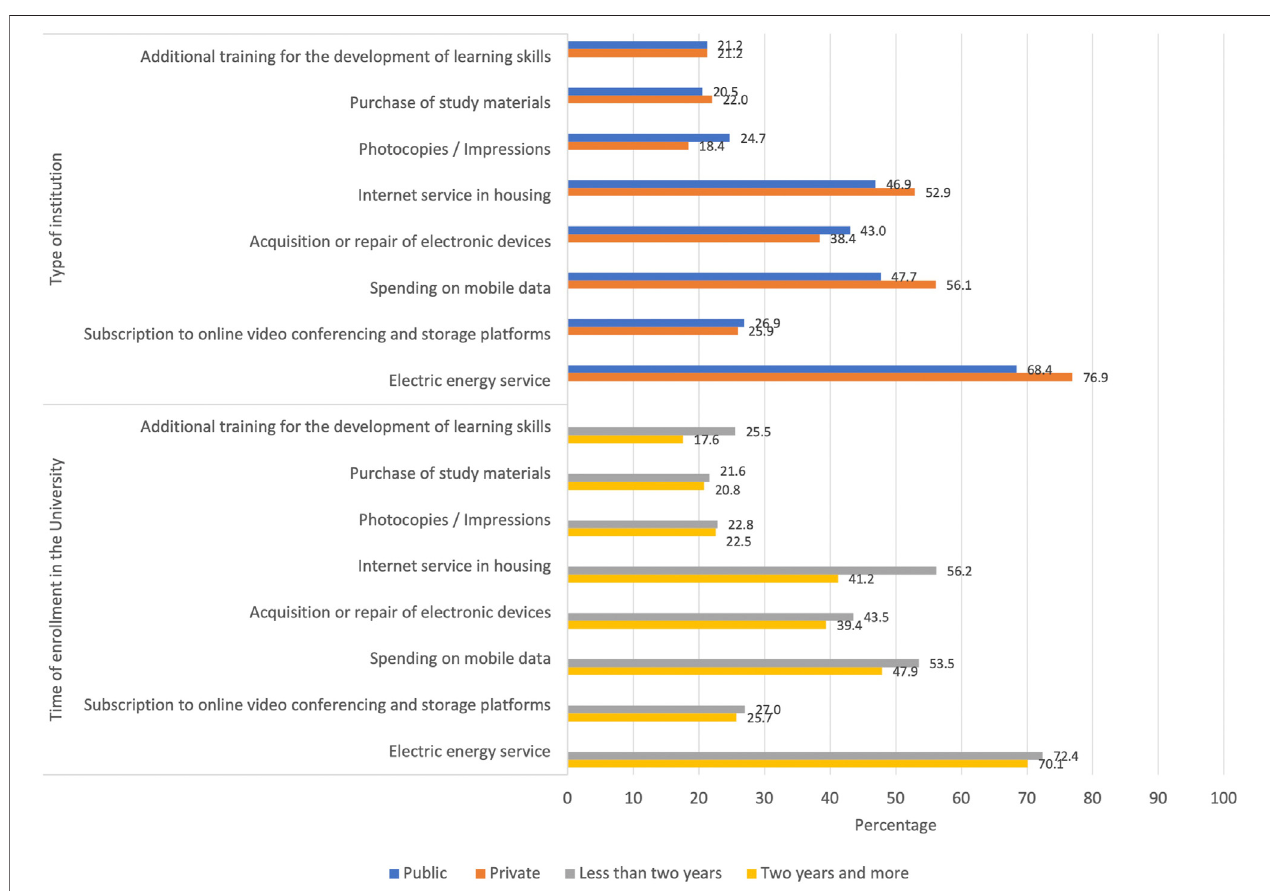
FIGURE7| Householdexpenditures increasedreportedbystudentsduetotheemergencyremoteteachingmodelimplementation,bytypeofinstitution,andtime of enrollment in the university.